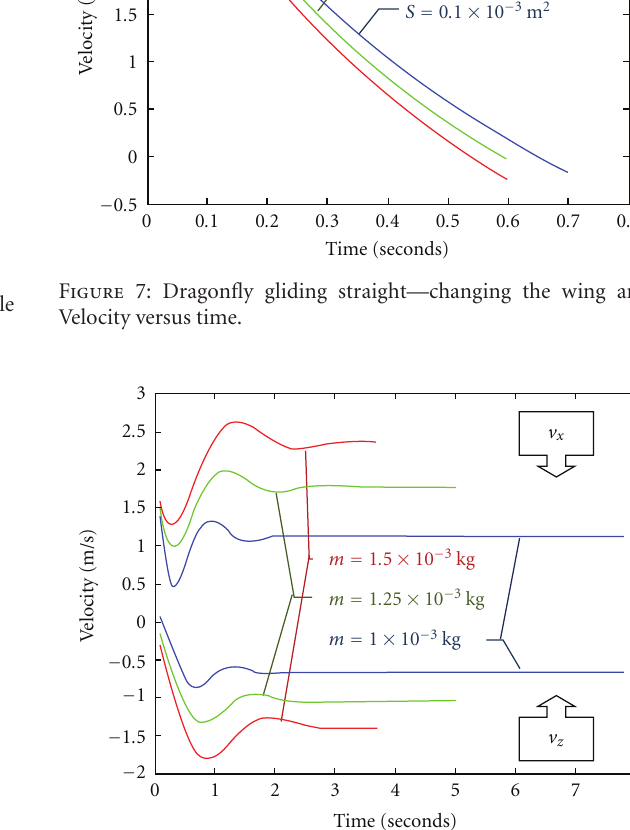
Figure 8: Dragonfly gliding down—changing the weight. Velocity versus time.